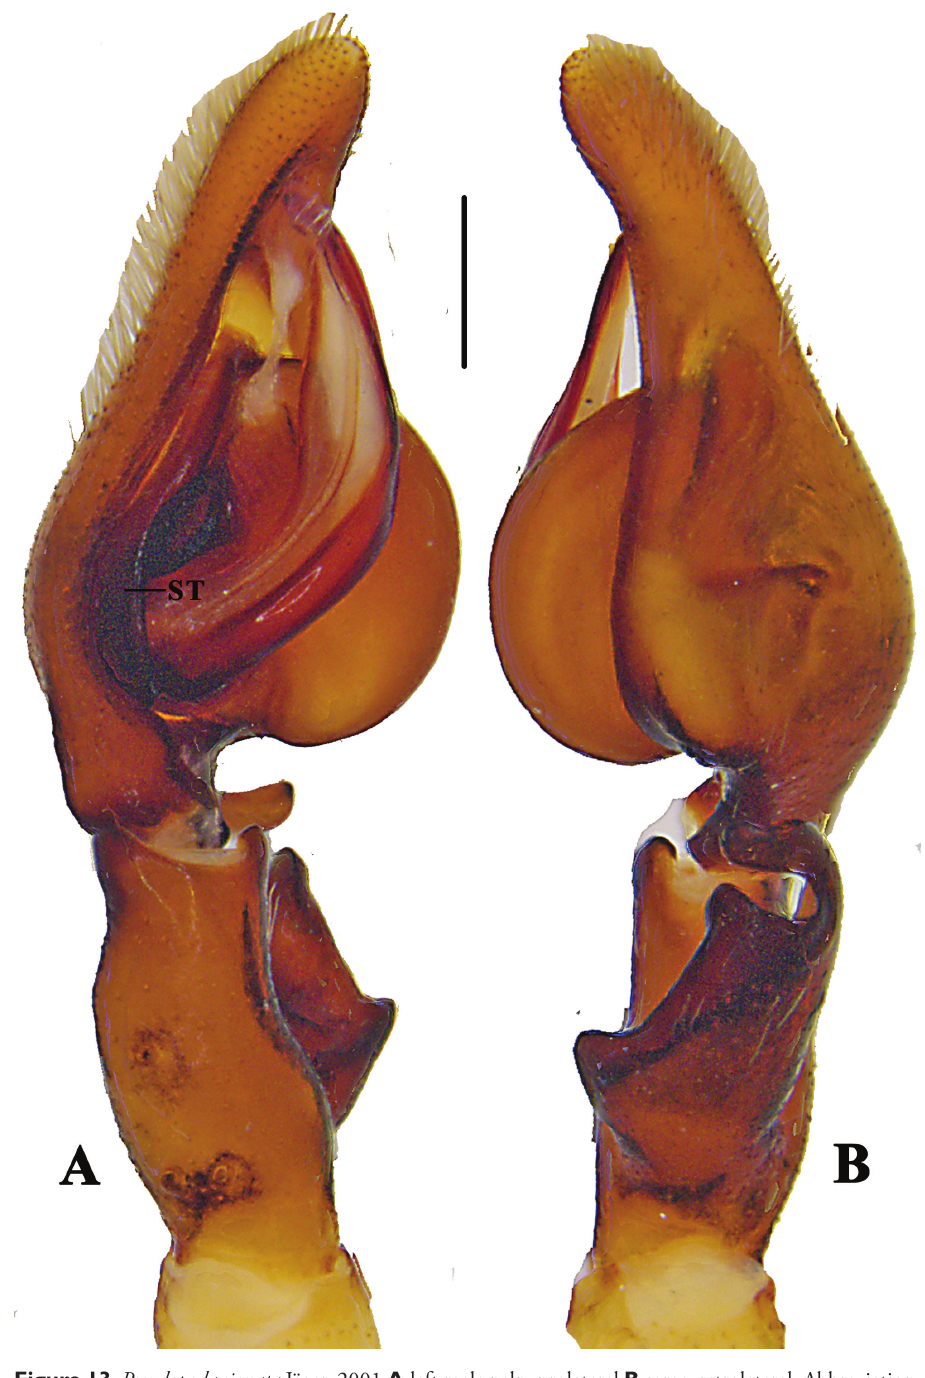
Figure 13. Pseudopoda signata Jäger, 2001 A left male palp, prolateral B same, retrolateral. Abbreviation: ST–subtegulum. Scale bar: 0.5